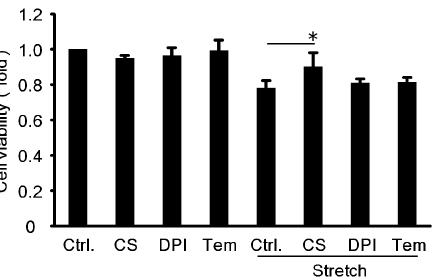
Figure 5. Effects of antioxidants on cyclic mechanical stretch- induced RASMC death. The cells were pre-incubated by CS905 (100 nM), diphenylene iodonium (5 m M), and tempol (1 m M) for 20 min prior to exposing to cyclic mechanical stretch by 15% elongation for 4 h and then incubated for 24 h. Cell viability was evaluated by MTT assay. Azelnidipine (CS905), diphenylene iodonium, and tempol are abbrevi- ated as CS, DPI, and Tem. Colorimetric analysis of each value was normalized by arbitrarily setting the absorbance value of the control cells (Ctrl.) to 1. Each value represents the mean 6 S.D. (n=4). The asterisks represent significant differences compared with the stretched control value (* P , 0.05, ** P , 0.01).